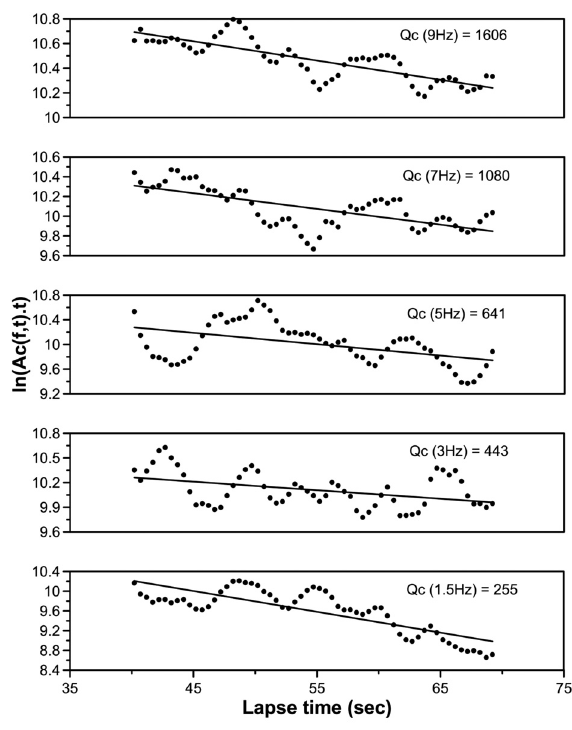
Figure 3. The variation of ln ( Ac ( f , t ). t ) with lapse time t along with the least-squares-fitted line for different central frequencies at SONA for the event of June 7, 2006.